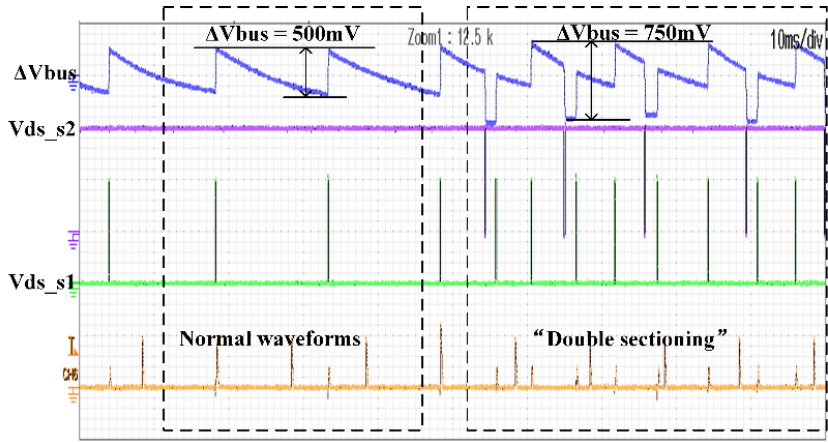
Figure 23. “Double sectioning”